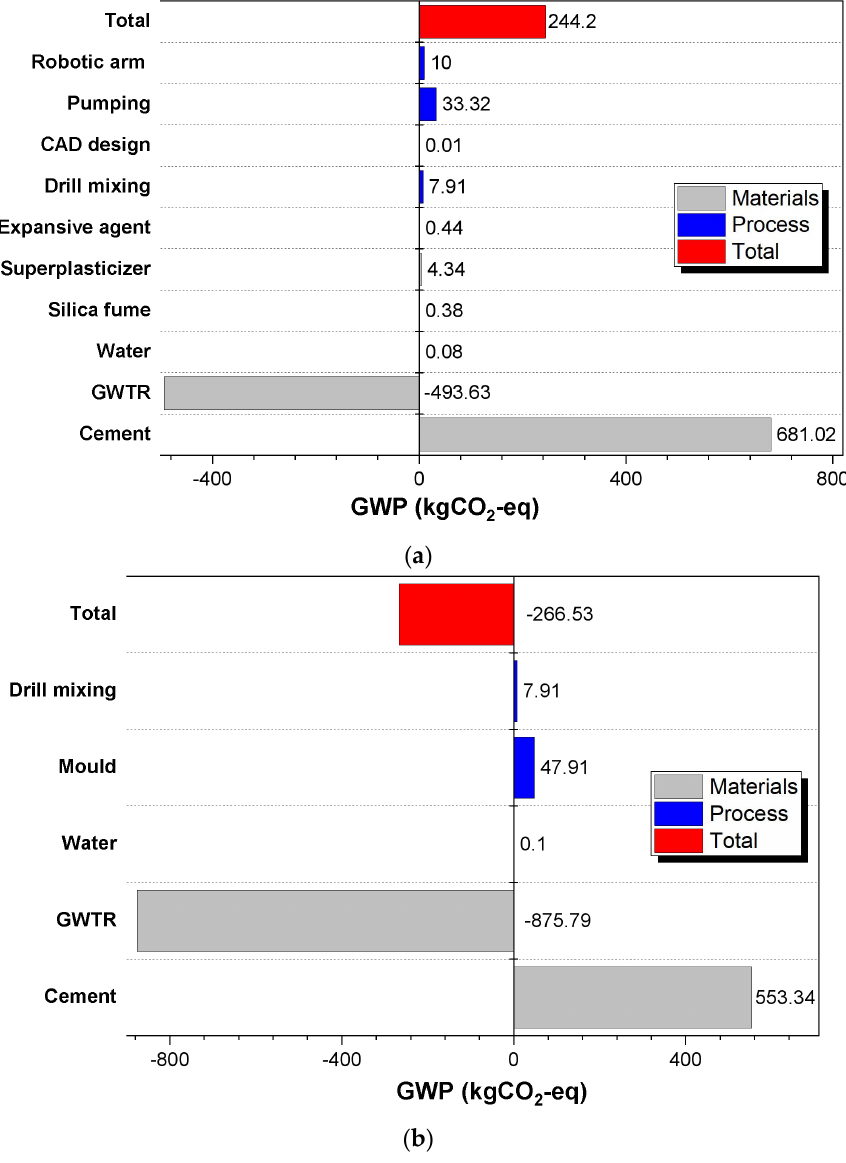
Figure 3. GWP results: ( a ) p-RuC and ( b ) c-RuC .